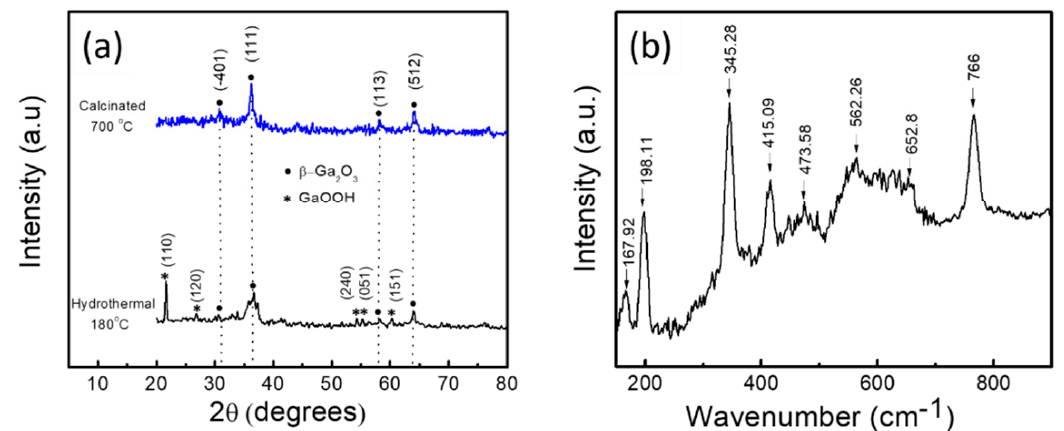
Figure 2. ( a ) HRXRD diffraction spectra of as ‐ synthesized β‐ Ga 2 O 3 and GaOOH. ( b ) Raman spectra of β‐ Ga 2 O 3 NRs.